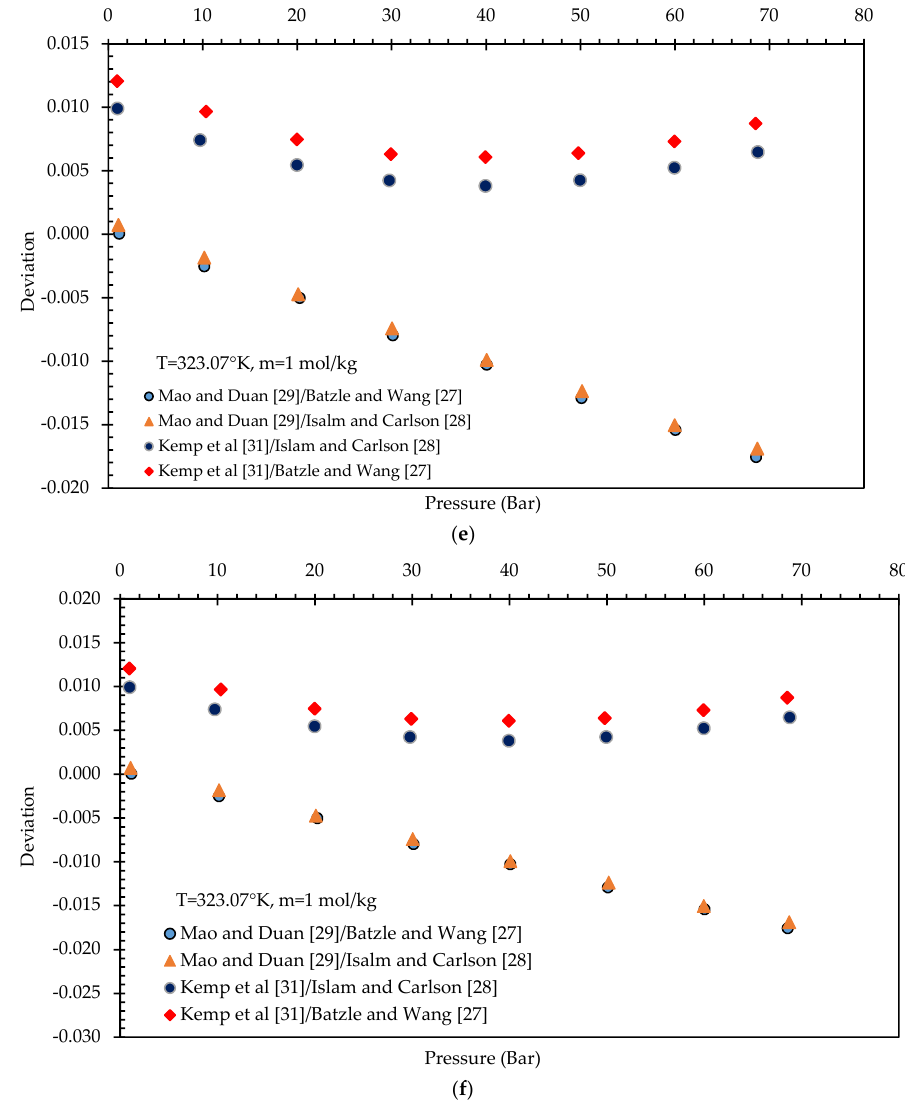
Figure 7. The deviation of various model estimates from experimental measurements of Al Ghafri et Figure 7. al. [30] at different temperature and CaCl 2 solution molalities versus pressure: ( a ) T = 323.07 °K, m = 1 mol/kg; ( b ) T = 323.07 °K, m = 6 mol/kg; ( c ) T = 348.04 °K, m = 1 mol/kg; ( d ) T = 348.04 °K, m = 6 ( a ) T = 323.07 ◦ K, m = 1 mol/kg; ( b ) T = 323.07 ◦ K, m = 6 mol/kg; ( c ) T = 348.04 ◦ K, m = 1 mol/kg; mol/kg; ( e ) T = 372.99 °K, m = 1 mol/kg; ( f ) T = 372.99 °K, m = 6 mol/kg. ( d ) T = 348.04 ◦ K, m = 6 mol/kg; ( e ) T = 372.99 ◦ K, m = 1 mol/kg; ( f ) T = 372.99 ◦ K, m = 6